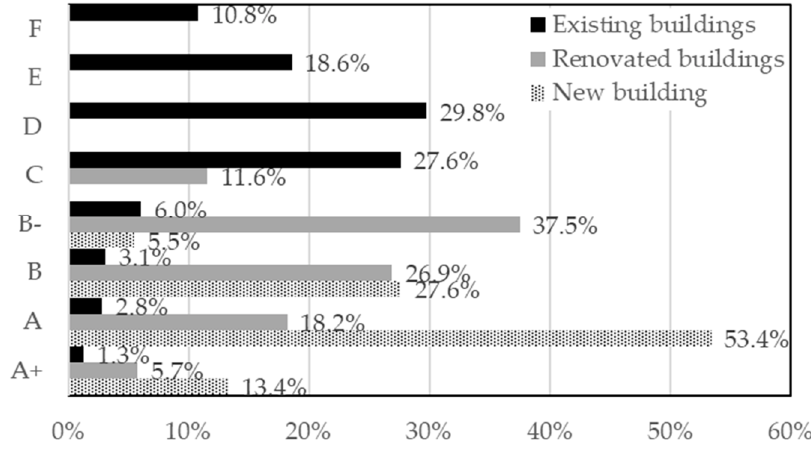
Figure Figure 4. Number of EPC issued since 2010 distinguishing new, renovated, and existing dwellings [25].